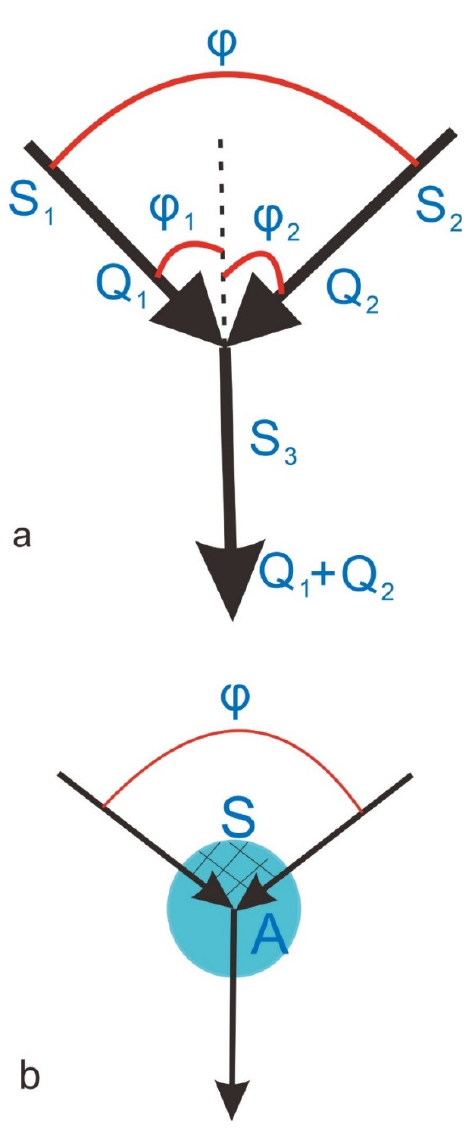
Figure A1. The definition of the different parameters to calculate the branching angle with ( a ) Seybold, 2017 and ( b ) Cang et al., 2019.